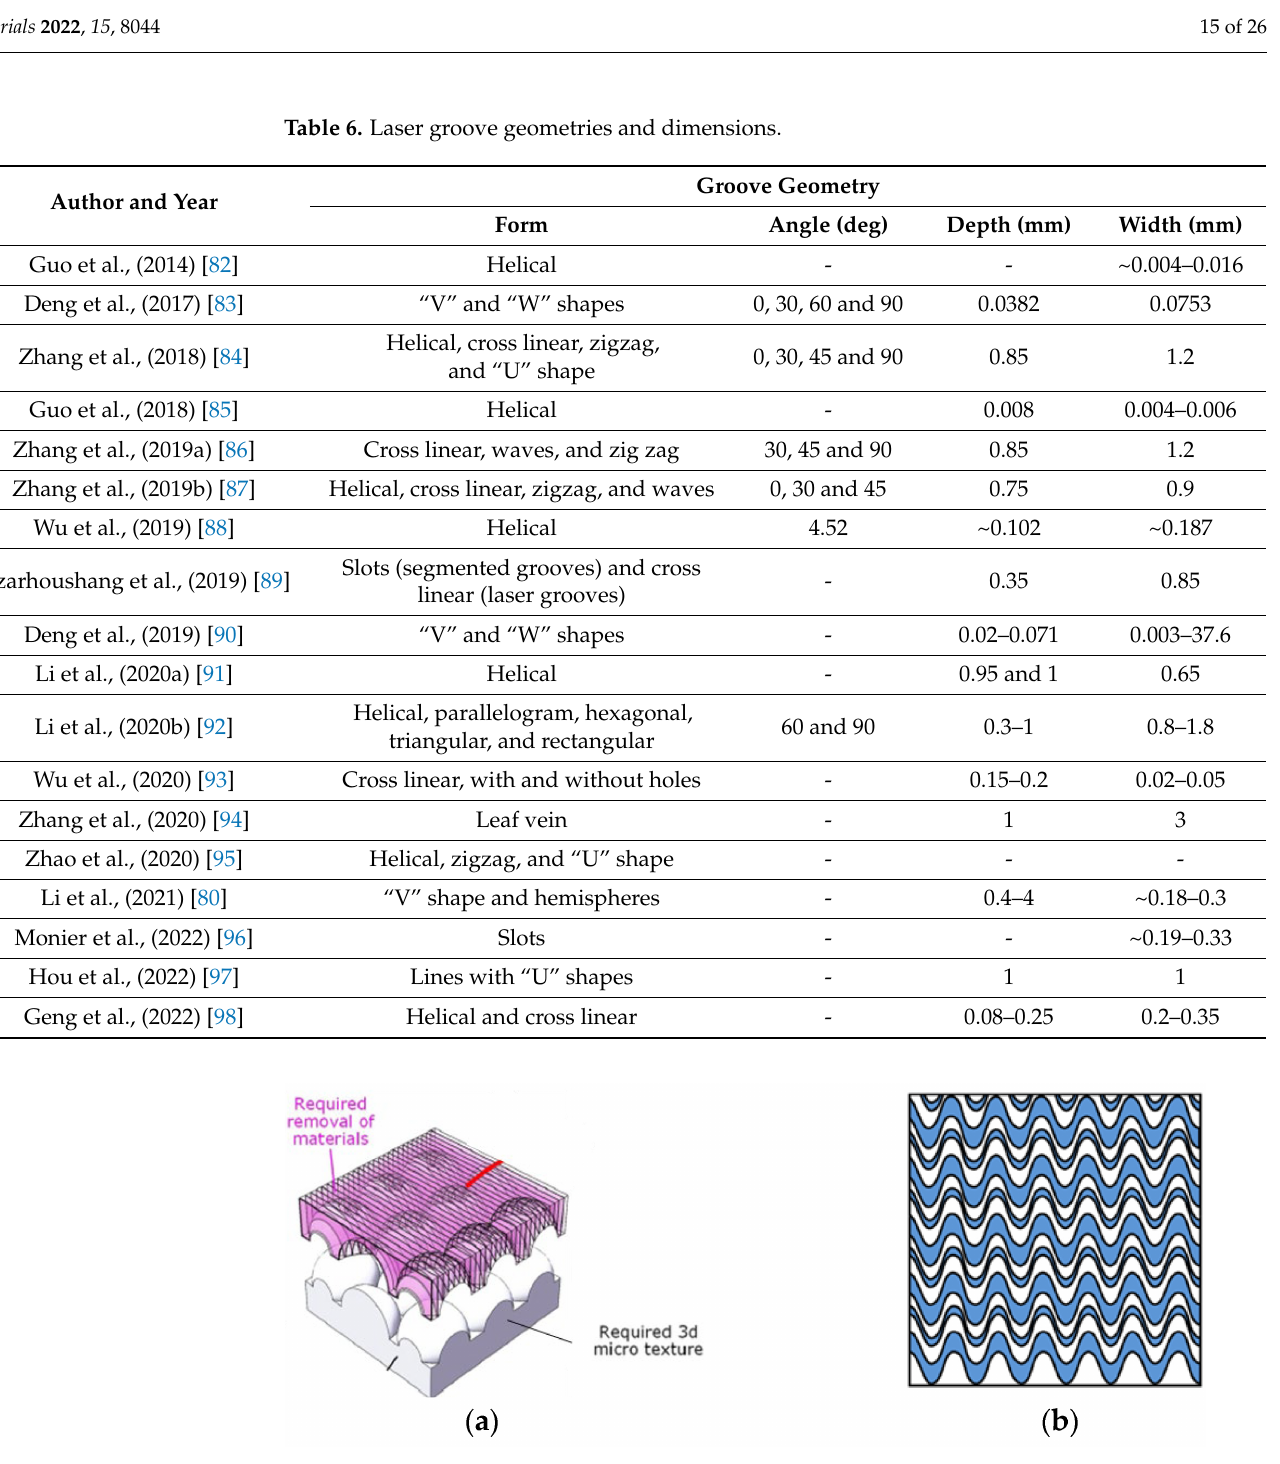
Figure 11. Groove geometries produced by the laser method: ( a ) hemispheres and ( b ) waves